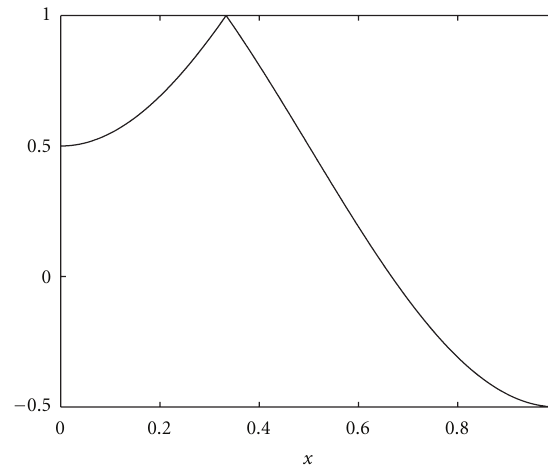
Figure 8: The graph of function 𝑓(𝑥) of Example